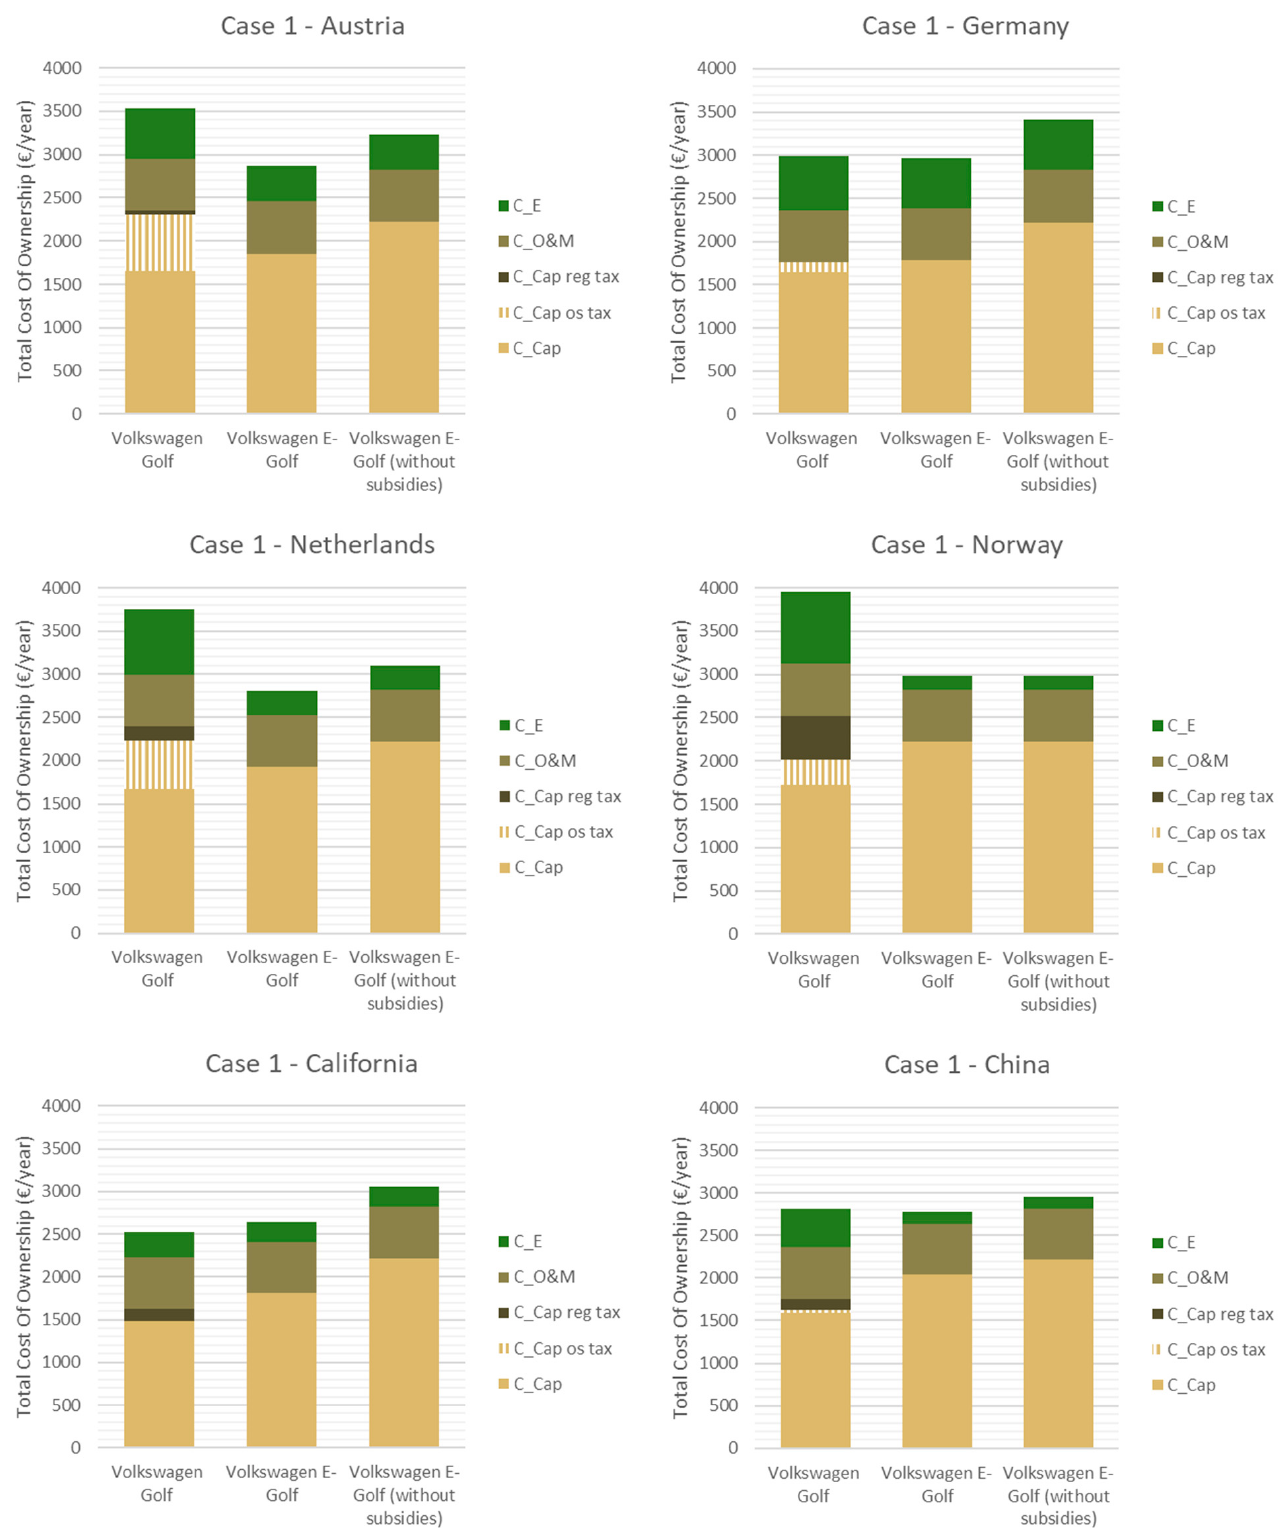
Figure 10. TCO: Case 1—Composition of the TCO in Case 1 for 2020.